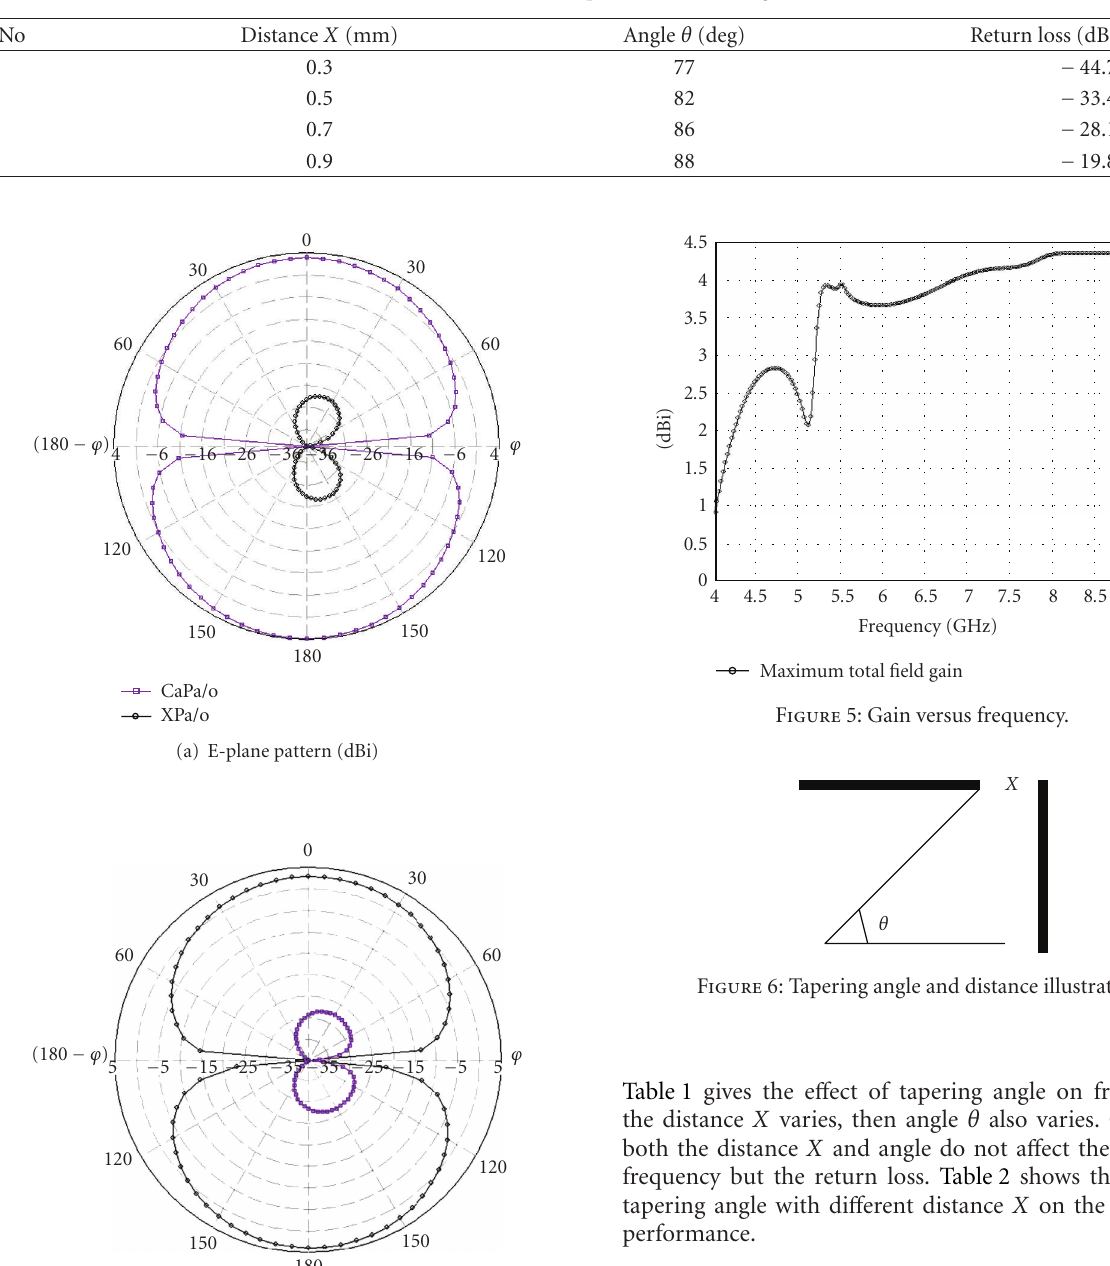
Table 2: E ff ect of taper distance and angle.